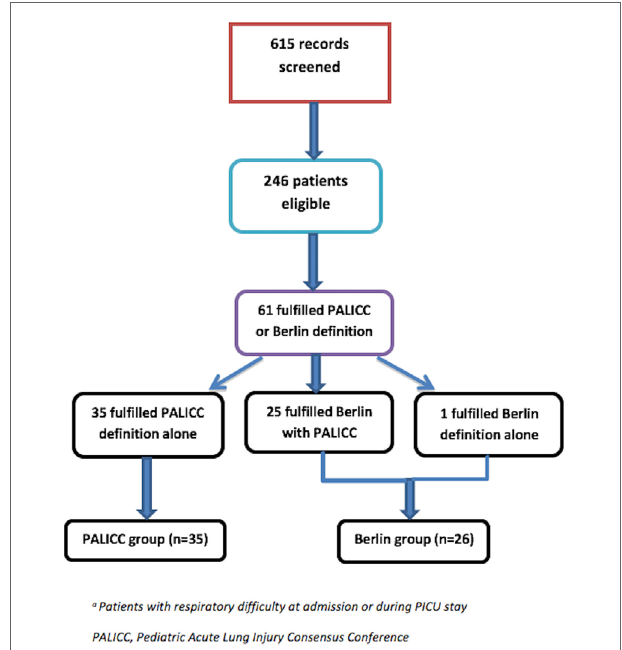
FigUre 1 | Study flow. *Patients with respiratory difficulty at admission or during Pediatric Intensive Care Unit (PICU)